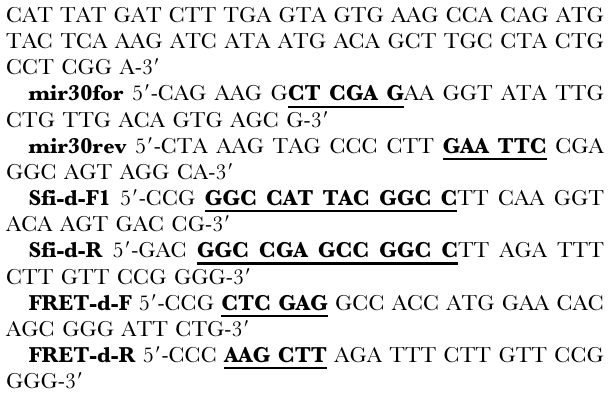
Figure S3 Stable expression of sh1CD81 increases TCR mediated activation without affecting surface TCR expression. (a) CD81 shRNAs does not affect surface TCR expression in stably transfected VL3.3M2 cells. Relative MFI of TCR b expression on the surface of VL3.3M2 cells that are untransfected (U), or stably transfected with empty pLMP constructs (LMP) or with pLMP-sh1CD81 constructs (sh1CD81) or single cell cloned stable sh1CD81 expressing clones (clone1 and clone2) was determined by flow cytometry and plotted as bar graphs. Surface TCR b expression of untransfected VL3.3M2 cells was set to 100. ( b ) Surface CD69 expression activated by anti- TCR + anti-CD4 co-crosslinking is inversely proportional to the level of surface CD81 expression. VL3.3M2 cells were crosslinked with plate bound anti-TCR + anti-CD4 antibodies and MFI of surface CD69 expression on empty LMP transfected (squares), sh1CD81 expressing (circles) and single cell cloned high sh1CD81 expressing clone 2 cells (triangles) were plotted for increasing antibody concentrations. Figure S4 Surface expression of CD81, CD9, TCR, CD5 and CD69 on the surface of CD81 2 / 2 and CD9 2 / 2 thymocytes and lymph node cells. (a) Surface CD81 and CD9 expression on CD81 2 / 2 (black histograms) and CD9 2 / 2 (grey histograms) on DP thymocytes shown in the gate defined in Figure 4. Isotype control staining is shown as a shaded histogram. (b) Surface CD81 and CD9 expression on CD81 2 / 2 (black histograms) and CD9 2 / 2 (grey histograms) on LN cells. (c) Surface TCR b , CD5 and CD69 expression on CD81 2 / 2 (black histograms) and CD9 2 / 2 (grey histograms) on CD4 (top row) and CD8 (bottom row) SP thymocytes. (TIF) Figure S5 CD81 2 / 2 LN CD4 + lymphocytes proliferate faster than WT cells. Frequency of proliferated ( . 1 cell division) cells after stimulation of CFSE-labeled purified LN CD4 + cells from B6 and CD81 2 / 2 mice. Histograms show CFSE expression in stimulated CD4 T cells and numbers in the left gate indicate the frequency of cells with . 1 division and the numbers in the right gate indicate un-proliferated cells.